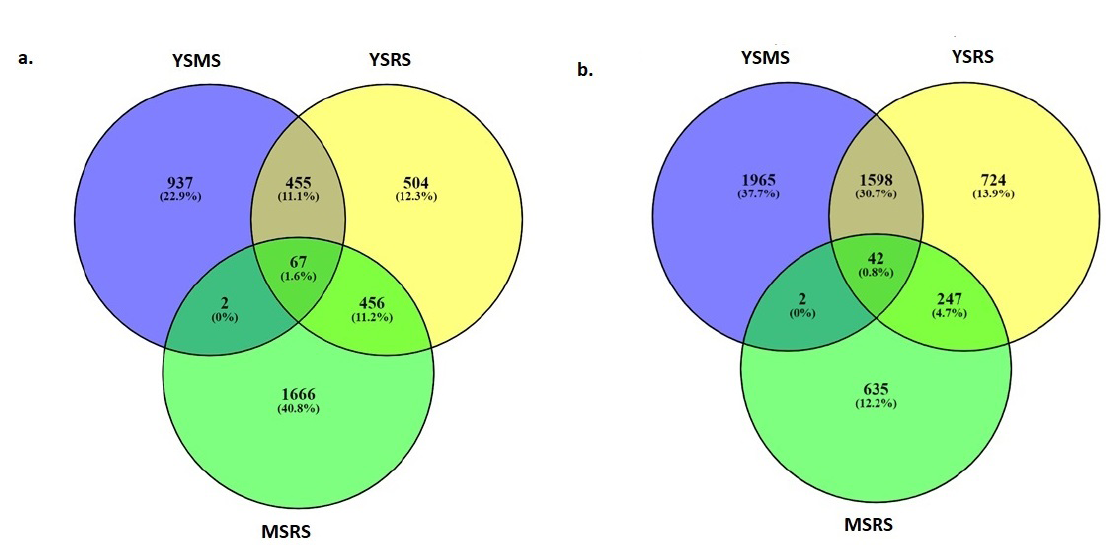
Figure 3 − a. Venn diagram for upregulated DEGs from three comparisons, namely YS/MS, YS/RS, and MS/RS. A total of 5,134 genes were expressed in all three stages. The number of tissue-specific genes are 1,965, 724, and 635, respectively. b. Venn diagram for upregulated DEGs from three coparisons, namely YSMS, YSRS, and MSRS. A total of 4,087 genes were expressed in all three stages. The number of tissue-specific genes are 937, 504, and 1,666, respectively.